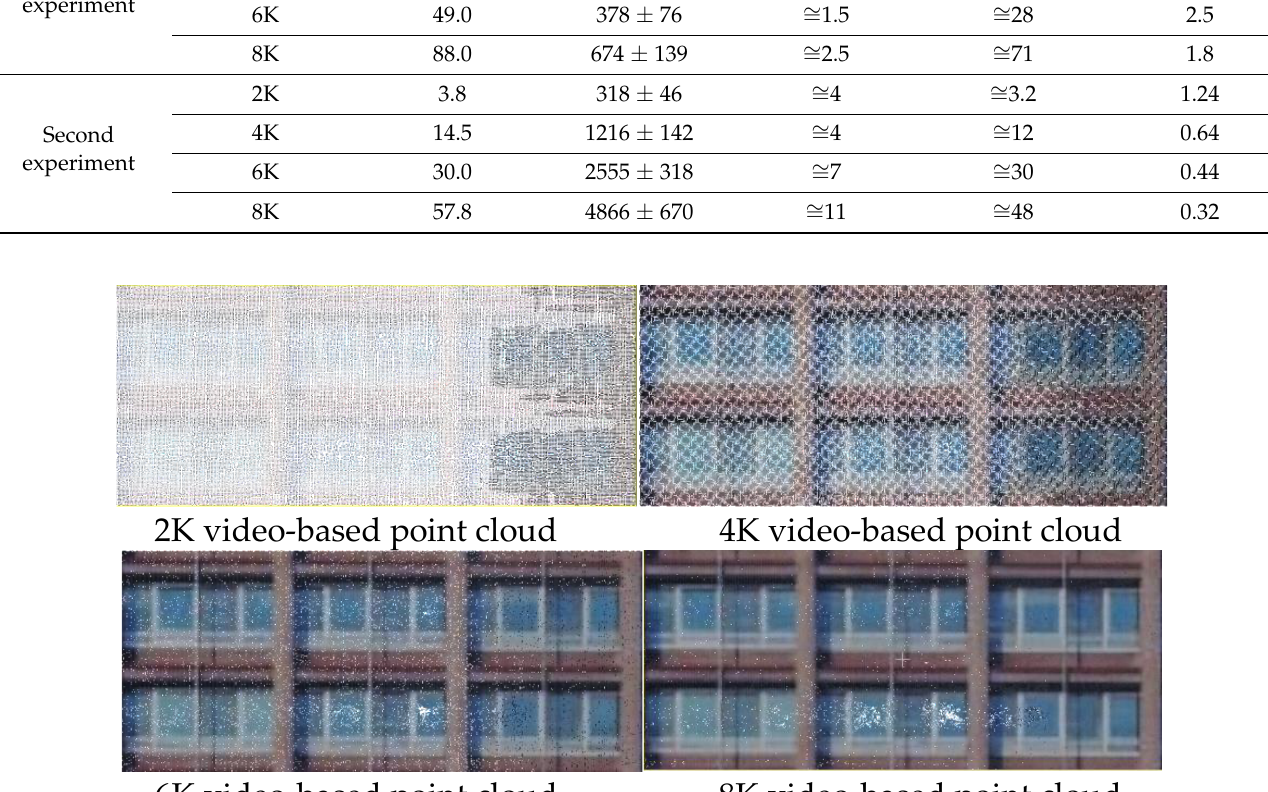
Figure 17. Sample point cloud (using middle ¼ dense reconstruction) of the second test building at the four indicated video resolutions.